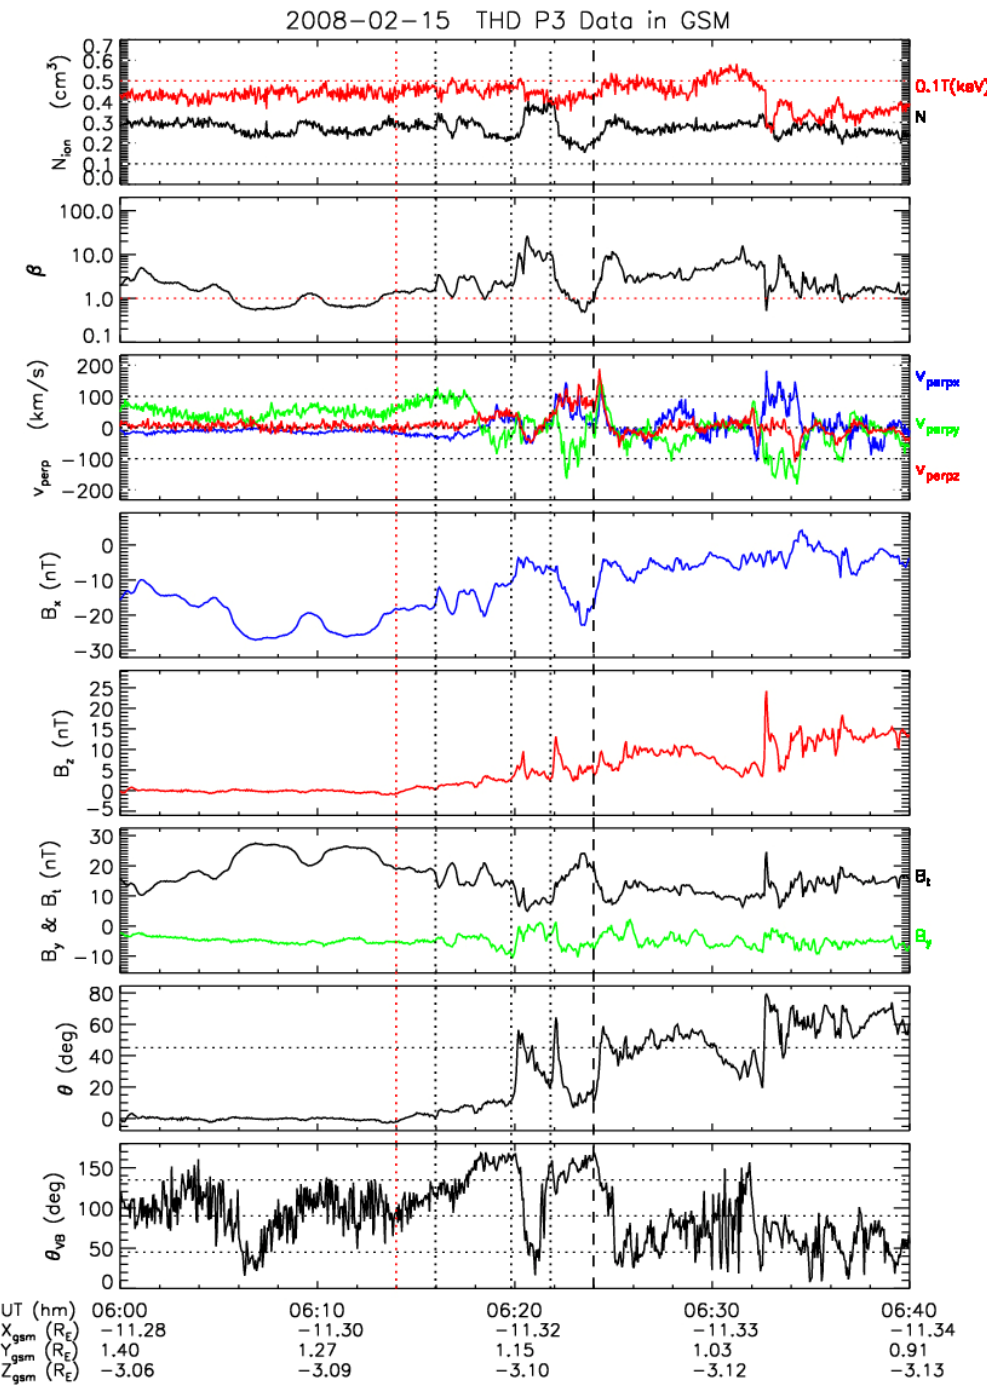
Fig. 3. Figure 3. THEMIS multiple probes observed the substorm occurred at 06:14 UT on 15 February 2008 in the near-Earth plasma sheet. Figure 3(a), 3(b) and 3(c) are from THA, THE and THD, respectively. The format of these three figures are the same, from top to bottom are hot ion density, N, (black line) and temperature T (red line 0.1T components of ion bulk flow v (black line) and B y (green line), the magnetic elevation angle θ =tan -1 (B z /(B 2 x +B 2 y ) 1/2 ), the angle between the magnetic field and the ion bulk flow θ Bv .